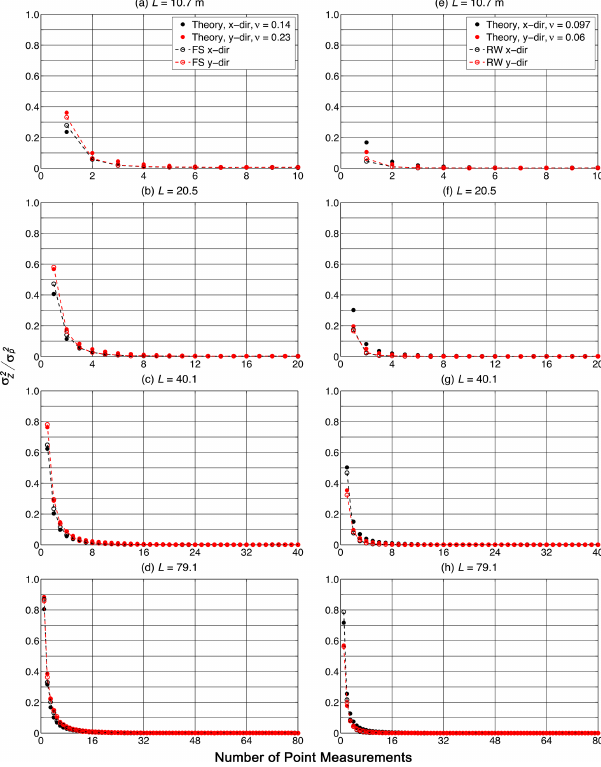
Figure 11. Theoretical and sampled normalized squared error . σ 2 p ) for the N -point pattern along a profile section in Fig. 5c, ( σ 2 Z and for profile section lengths ( L ) between 10 and 80m in FS and RW. The solid point markers are the theoretical error from (10) us- ing exponential decay exponents derived from the functions fitted to the sampled correlograms of the two surfaces in the x and y di- rections, while the circle markers with the dotted lines correspond to the sampled error for profiles in FS (a–d) and RW (e–h)